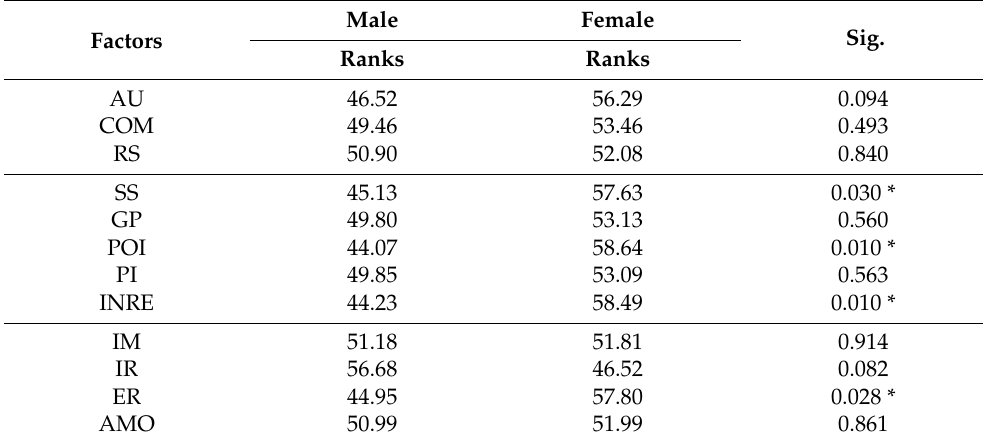
Table 2. Mann–Whitney U-ranks: gender differences.